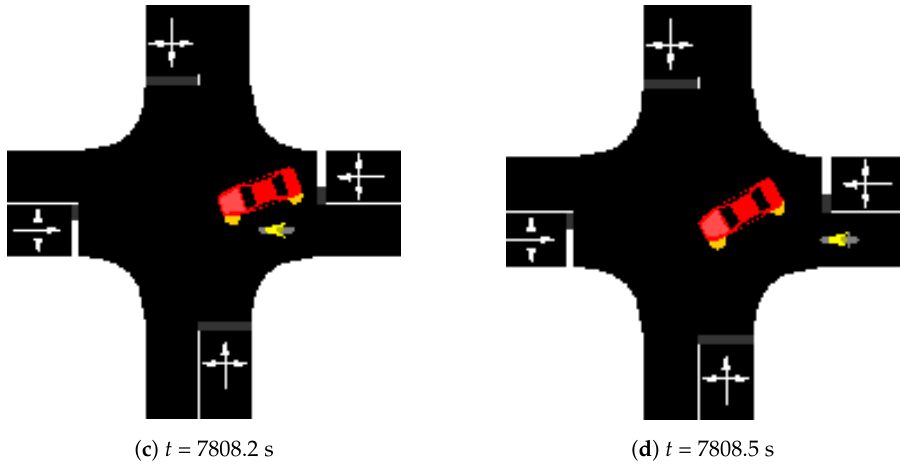
Figure 5. Near-collision example: Scenario A, seed